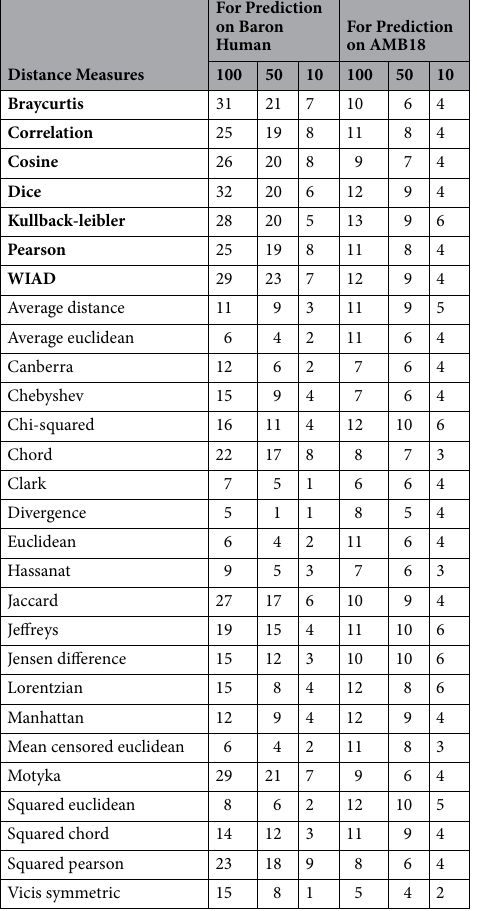
Table 1. The number of erroneous samples that can be correctly detected in the 100, 50, and 10 lowest NPR scores, and RF scores obtained by training on Baron Human and AMB18 and testing on their test sets with individual distance measures. Distance measures that perform well jointly in both datasets are marked in